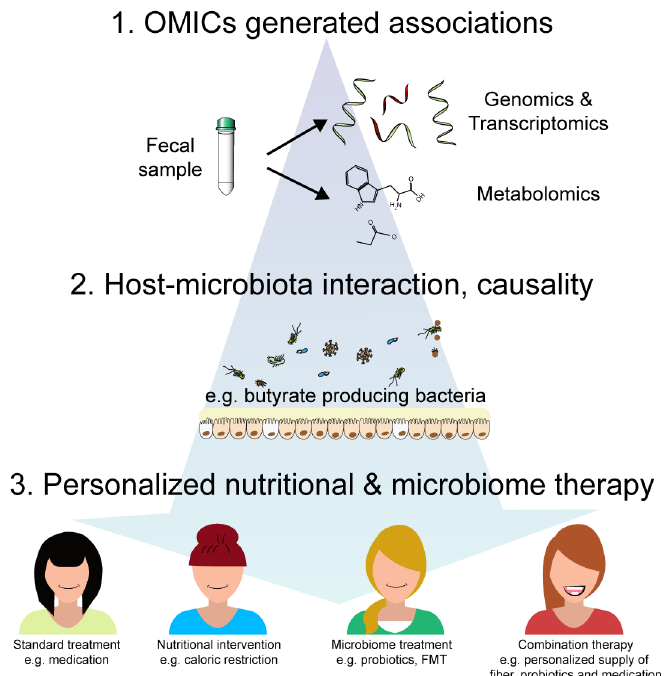
Figure 2. Roadmap for personalized therapy combining nutrition, microbiome and classical medication. In the past decade, OMICS studies based on next-generation sequencing or metabolomics revealed the associations of alterations in the genome, transcriptome or metabolome with disease states. Longitudinal studies allowed retrospective correlations of dysbiotic signatures with early, late or acute disease. Functional studies of host–microbiome interactions mainly using gnotobiotic animal model-established causality and identified, for example, the central role of the microbiome-related SCFAs and tryptophan metabolites for the regulation of inflammatory responses. Standard patient care (e.g., medication), nutritional interventions (e.g., caloric restriction) or microbiome-directed treatments (e.g., probiotics or fecal microbiome transfer (FMT)) all have beneficial physiological